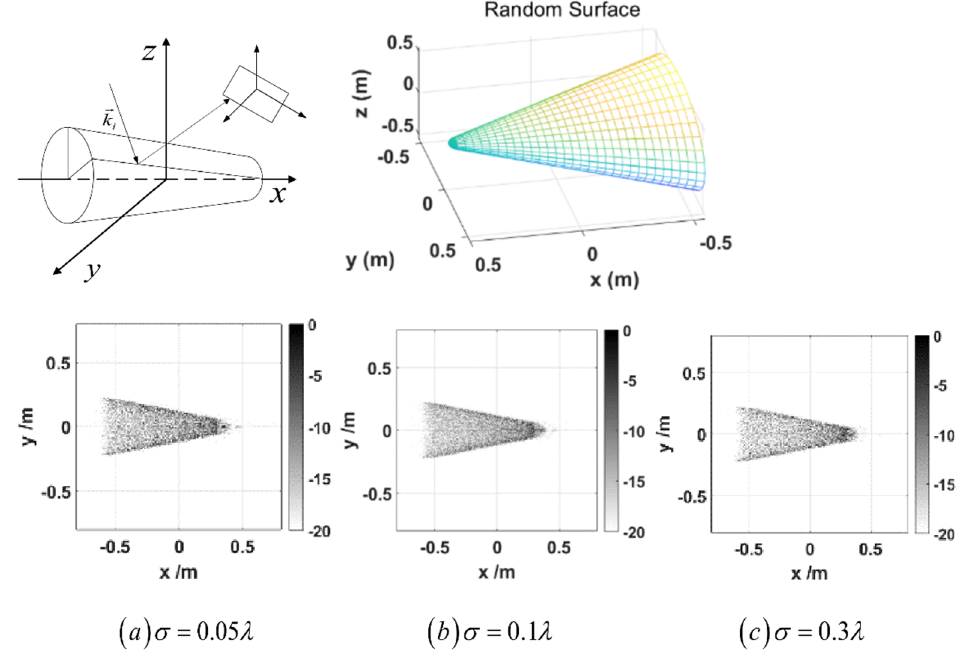
Figure 4. The effect of different root mean square heights on ISAL imaging of blunt-nosed cones. ISAL imaging of double cones with different roughnesses and rotation angles was simu- lated, and the simulation scale of the double cone was: the height of the double cone was 1.34 m, the radius of the bottom surface of the double cone was 0.27 m, the surface material was aluminum, the center frequency of the incident wave was 1.9346 × 10 14 Hz, and the corre- sponding wavelength was 1.55 μm. At this wavelength, the complex refractive index of alu- minum was 1.5785 + 15.658i, the relative permittivity was (−242.68, 49.5), and VV polarization was used. The frequency bandwidth was 3 × 10 9 Hz, the sampling point of the frequency was 16, the range of the rotation angle was (175°, 185°) and (265°, 275°), the unit angle interval of the rotation angle was 0.00008°, and the number of sampling points of the rotation angle was 75,000. The incident angle was 30°, and the correlation length was 1.55 μm. The ISAL imaging in Figure 5 clearly shows the shape of the double cone, which proves that ISAL imaging can clearly distinguish the rough double cone at different rota- tion angle ranges (under different symmetry axes) at a small rotation angle (10°). This is also different from the ISAL imaging of the blunt-nosed cones. For any rough target, the selected angle range can be different depending on the symmetry axis, but a clear ISAL image with a small rotation angle can be achieved. As the root mean square height de- creases, the surface of the double cone becomes smoother, and the scattering distribution mainly comes from coherent scattering, concentrated at the edge of the double cone, so the edge of the double cone becomes brighter.